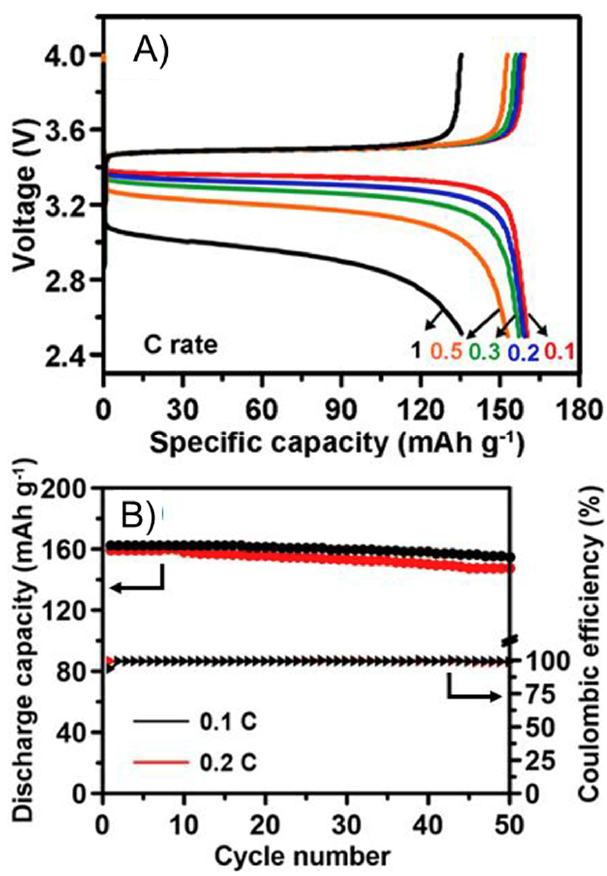
Figure 5. ( A ) Specific capacity in a Li-POSS and PEO-co-PPO polymer electrolyte-LFP cell at room temperature cycled at various rate between 2.5 and 4.0 V. ( B ) Capacity of the Li-POSS and PEO-co-PPO polymer electrolyte-LFP cell after 50 cycles at 0.2 and 0.1 C. Journal of Power Sources, 2020.